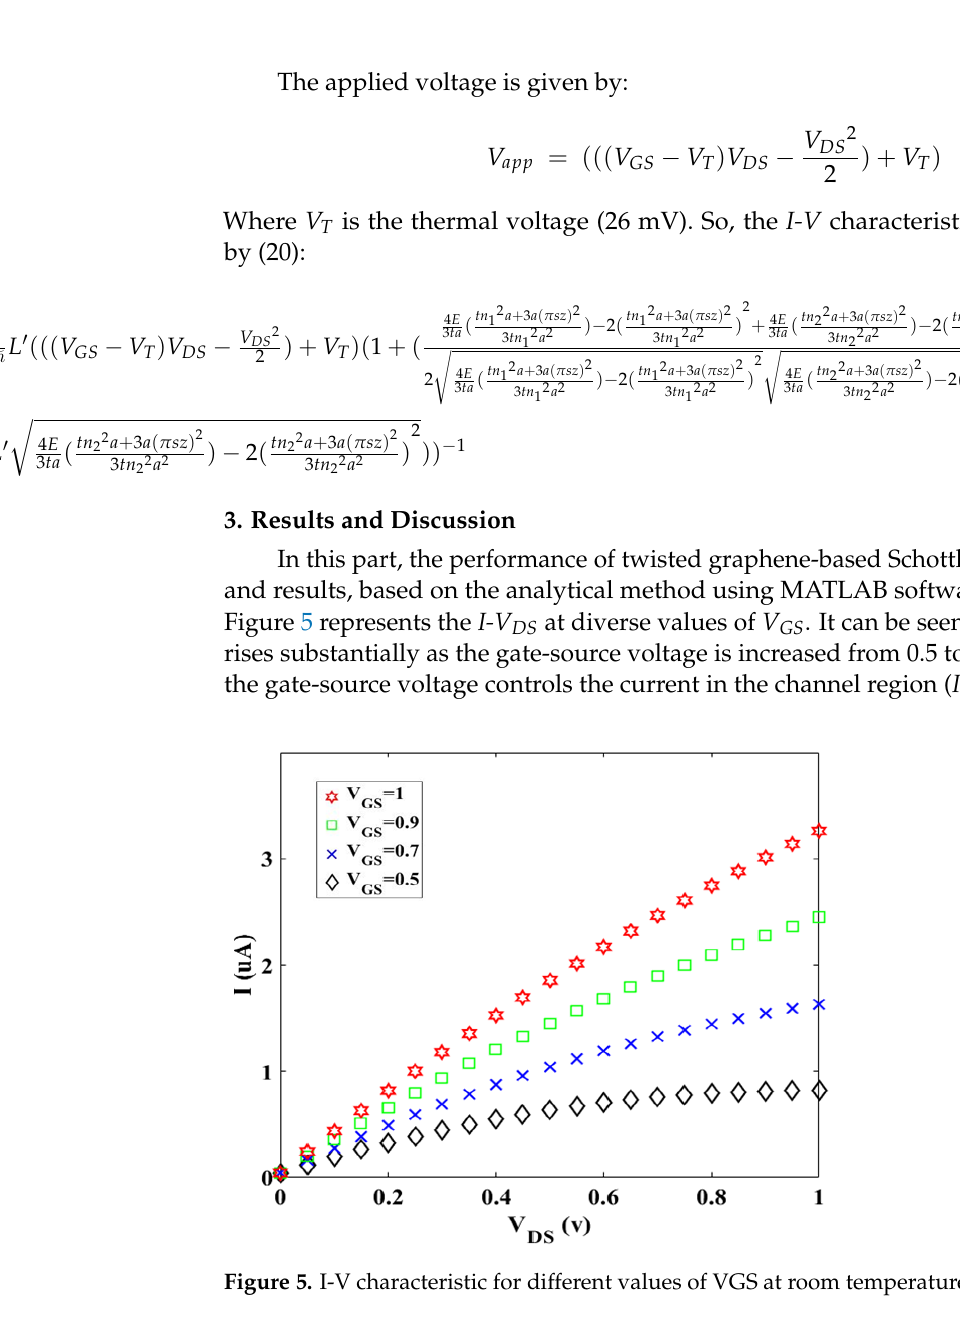
Figure 6. I-V characteristic for different values of channel length (in nm) at room temperature ( Z = 10 and S = 5). Although the S and Z based on Figure 3 have an inverse relation, nevertheless each of them has a reverse effect on transistor performance, which means that increasing in S or Z (separately) leads to the decrease in drain current that is controlled by the gate-source voltage. In the other words, small diameters of twisted graphene led to the transportation of electrons in one dimension, hence, the drain current increases [30]. In fact, the Fermi